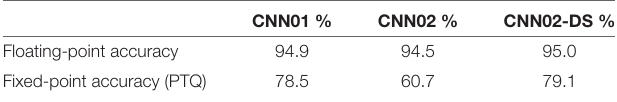
Convolution kernel dimension (first conv.) Convolution kernel dimension (second conv.)